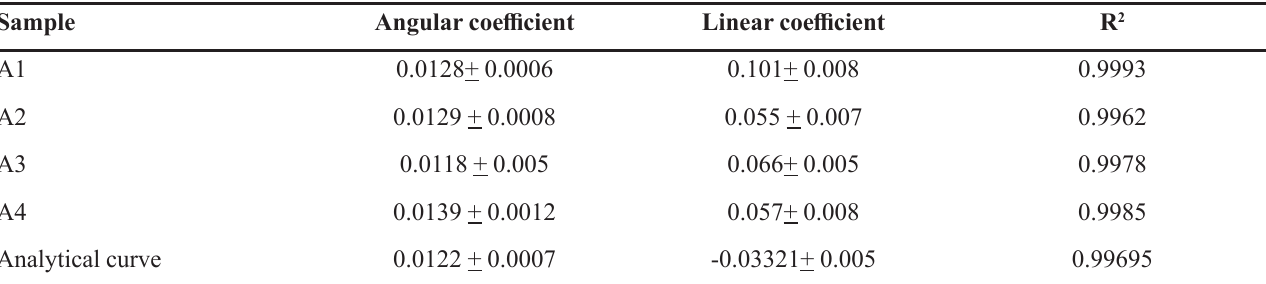
TABLE I - Comparison between the analytical curves and the analyte addition curves Sample